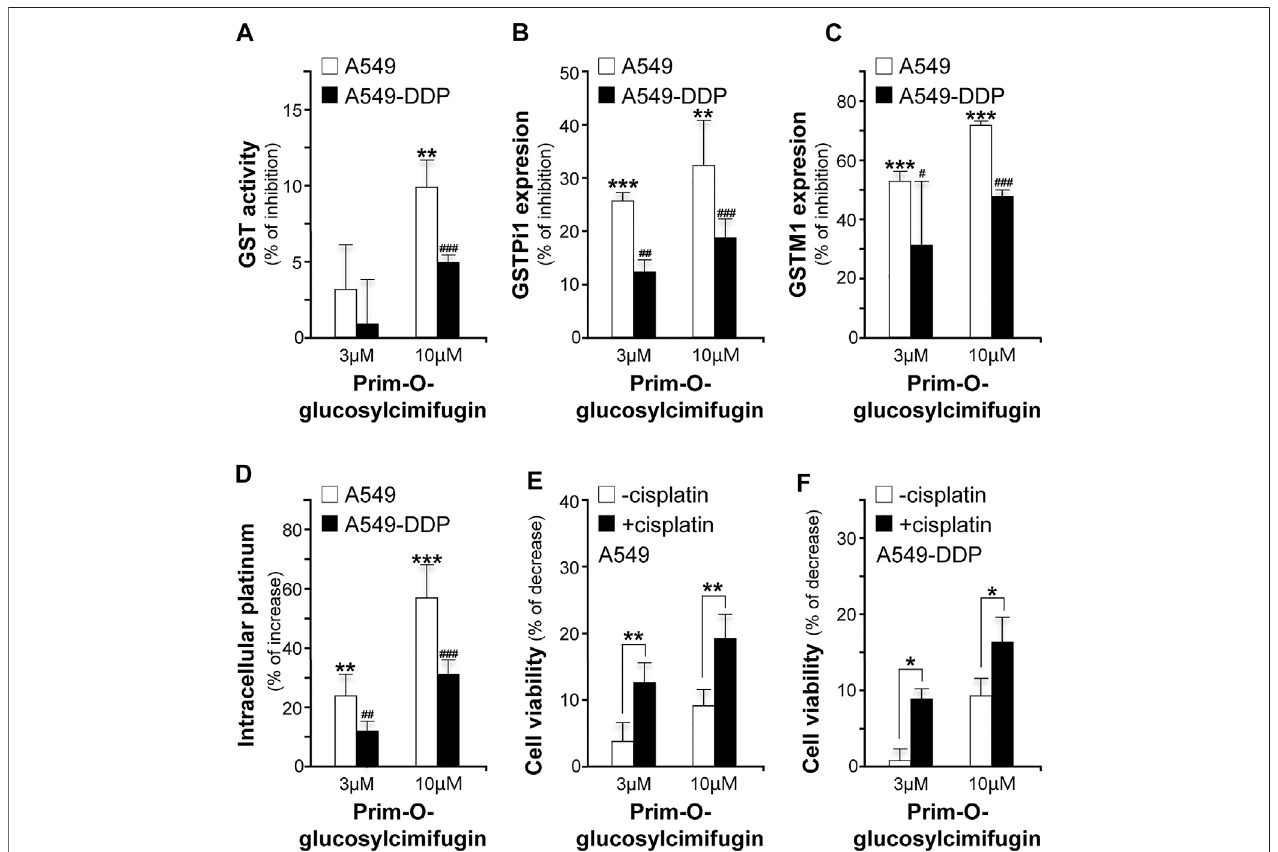
FIGURE 8 | Identi fi cationofprim-O-glucosylcimifuginasanactiveingredientofYPFS inreversing cisplatin chemo-resistance. Prim-O-glucosylcimifugin (3 and 10 µM) wereappliedontoculturedA549andA549-DDPcells.AssaysofGSTactivity( A ),geneexpressionofGSTPi1( B )andGSTM1( C ),measurementofintracellularplatinum (D) , andcytotoxicactivity( E , F )wereperformedandanalyzedasdescribedin Figures1 - 3 .Valuesareinmean ± SEM, n (cid:2) 3.*or#, p < 0.05,**or##, p < 0.01,***or###, p < 0.001.